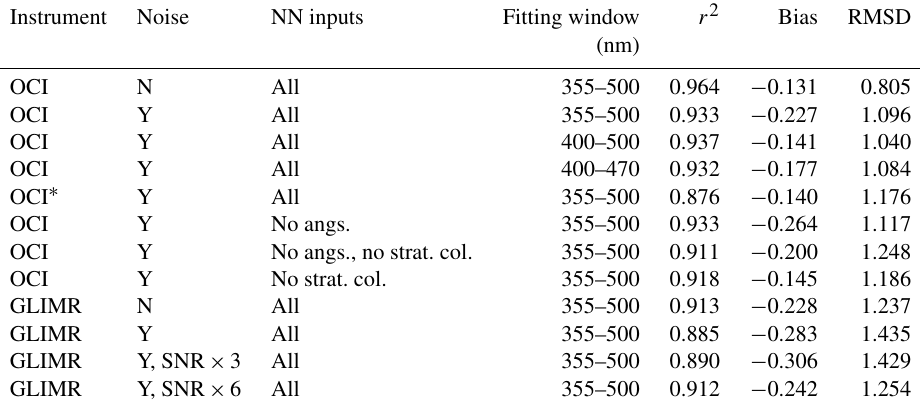
Table 2. Statistical comparison of SCD retrievals for row 1 simulated with the SNR models from Fig. 1 for OCI and GLIMR, using 17390 independent data points on 28 January 2005 (day not used in training, unless otherwise noted) and simulated OCI and GLIMR NO 2 SCDs. “All” refers to the use of all spectral data from the fitting window along with cosines of the solar zenith and relative azimuth angles (angs.) as well as the stratospheric column (strat. col.); statistics include the root-mean-square difference (RMSD), bias, and variance explained ( r 2 ) of the SCD. The bias and RMSD are given in units of 10 15 molec.cm − 2 . Unless indicated under the noise column, all results with noise (indicated by “Y”) use the SNR with no assumed spatial binning, as discussed in the text.